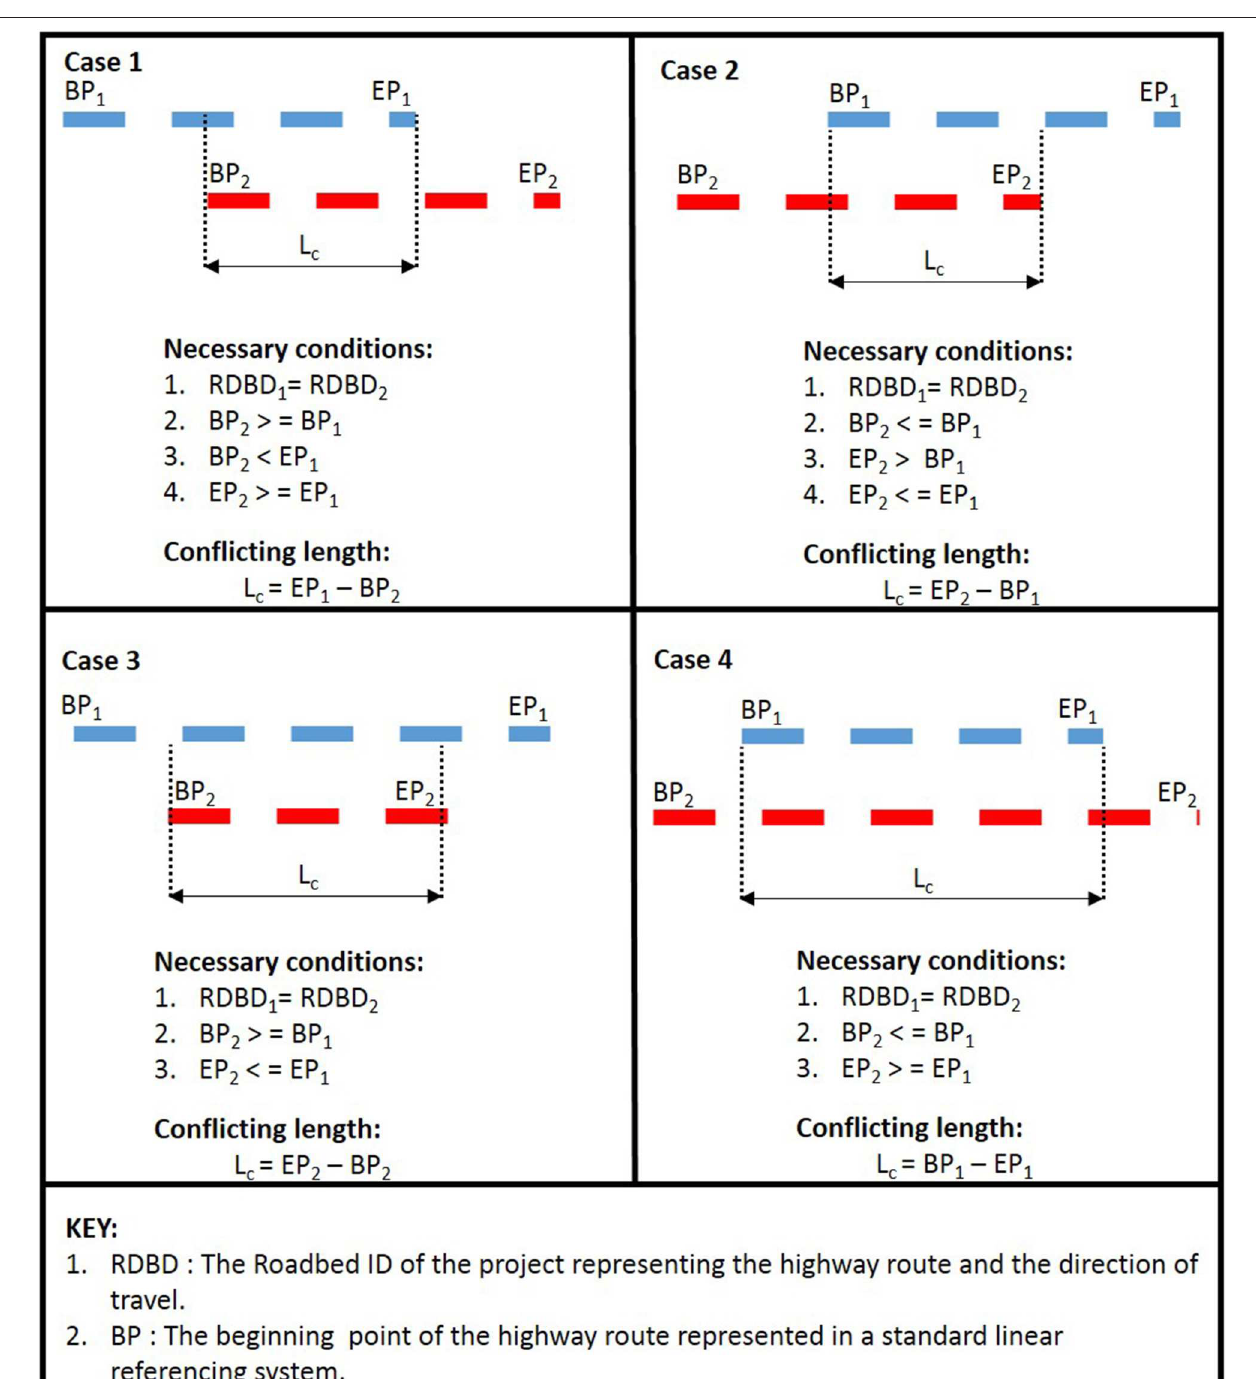
FIGURE 4 | Configurations of spatial conflicts among highway projects.